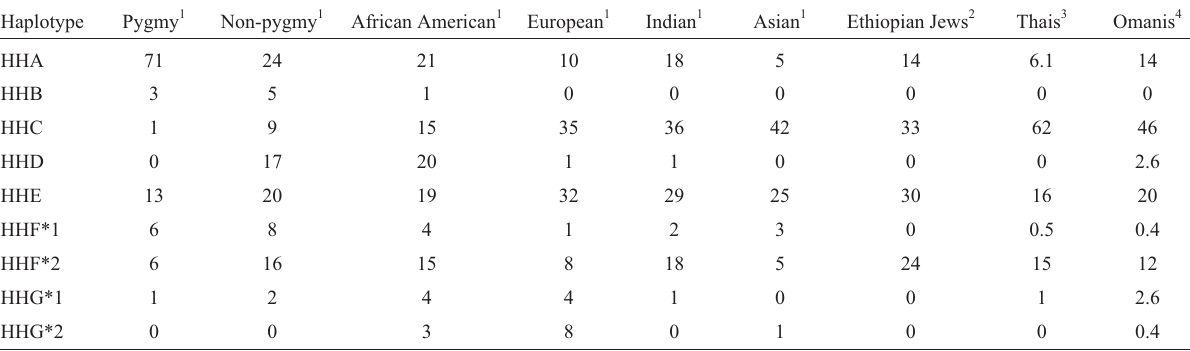
Table 3 - CCR5 haplotype frequency distribution (%) among populations.